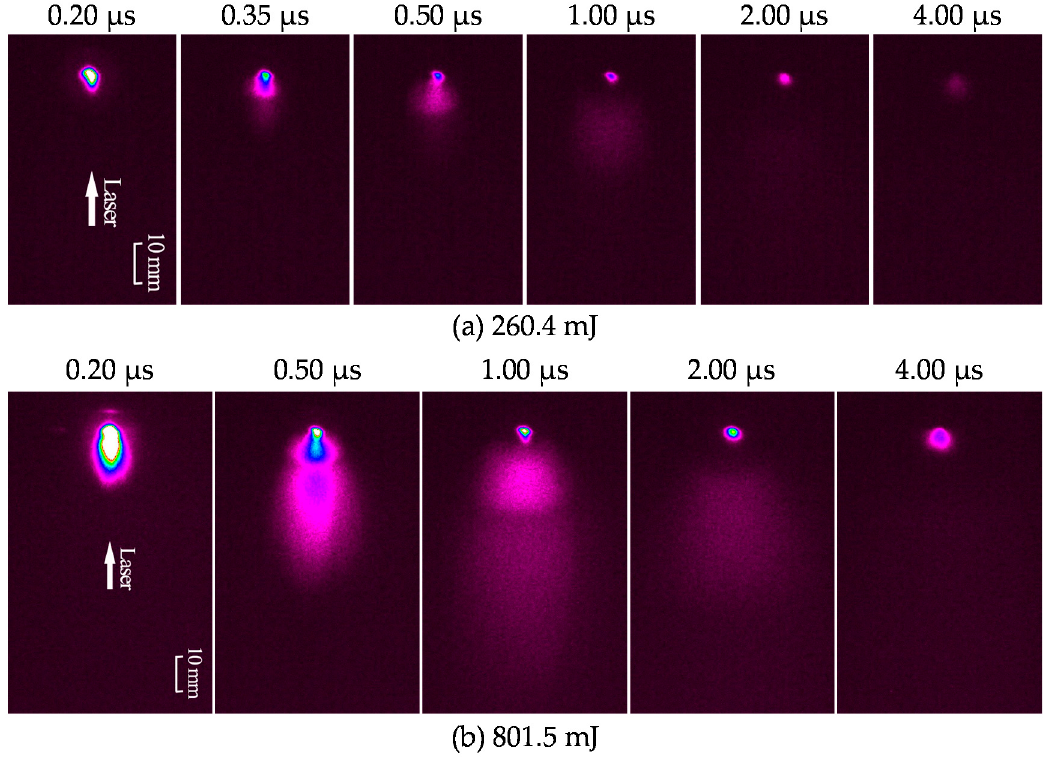
Figure 14. The evolution process of laser ablation plume at different laser energy (ambient pressure 0.005 Pa and 26.5% Al).